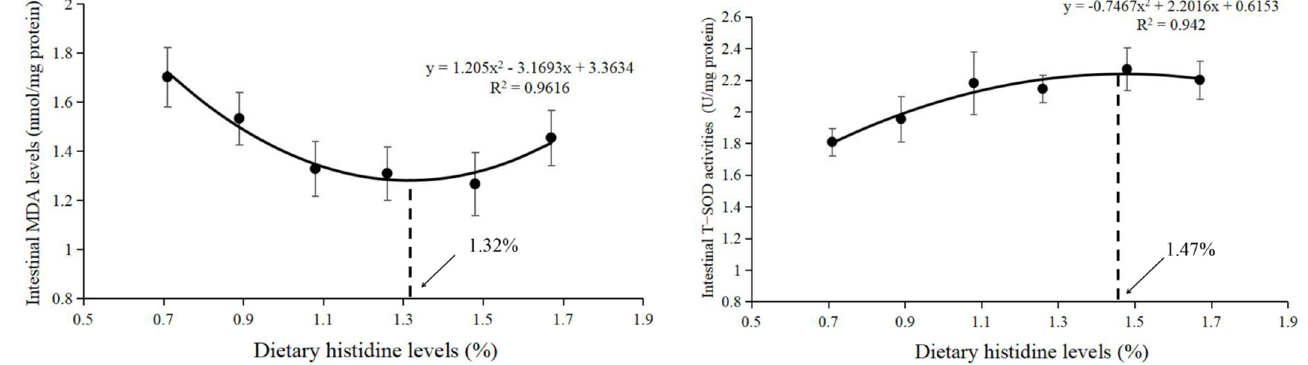
Figure 2. Quadratic regression analysis of MDA and T-SOD against graded different levels of dietary histidine.